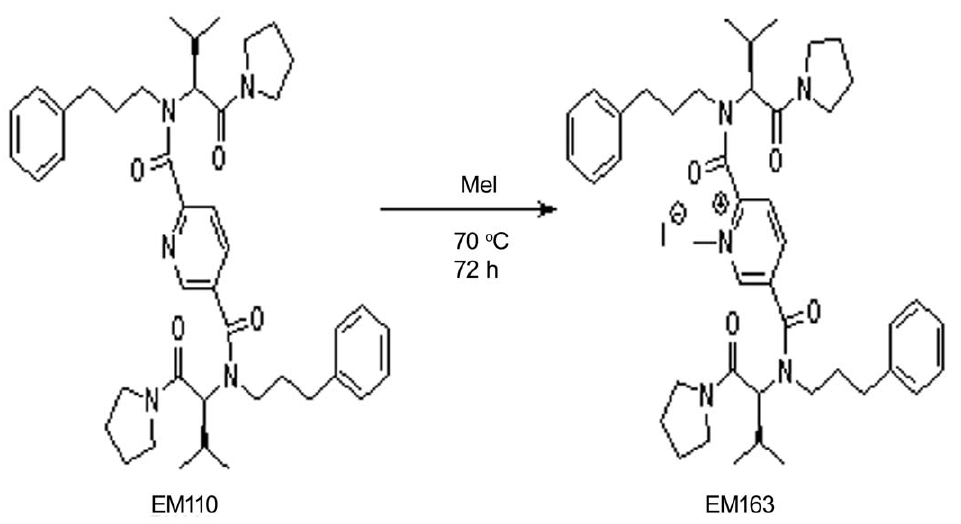
Figure 1. Synthesize of compound EM-163. EM-163 was synthesized from compound EM-110 as described in Materials and Methods.